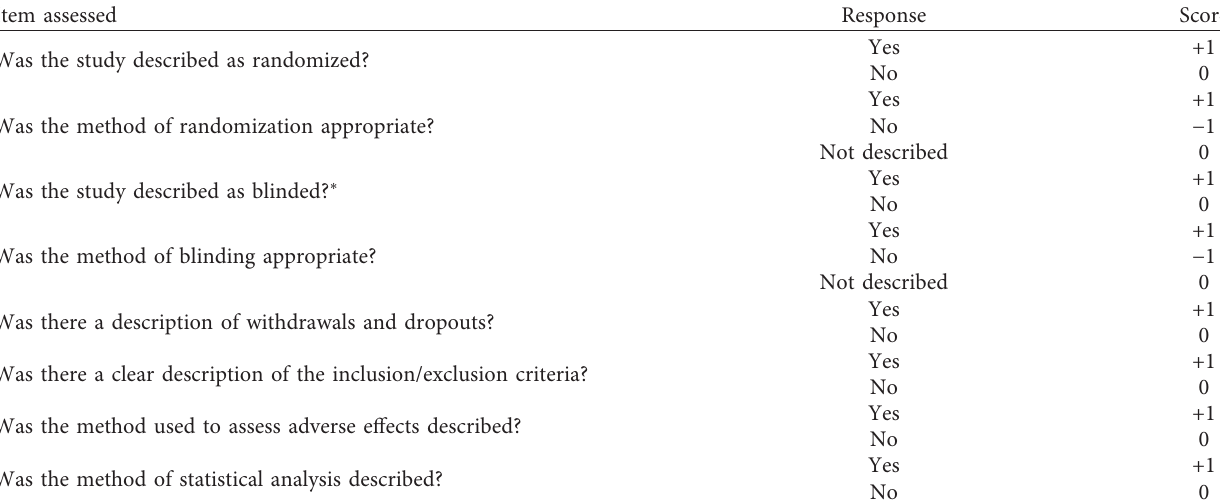
Table 1: The modified Jadad scale with eight items.